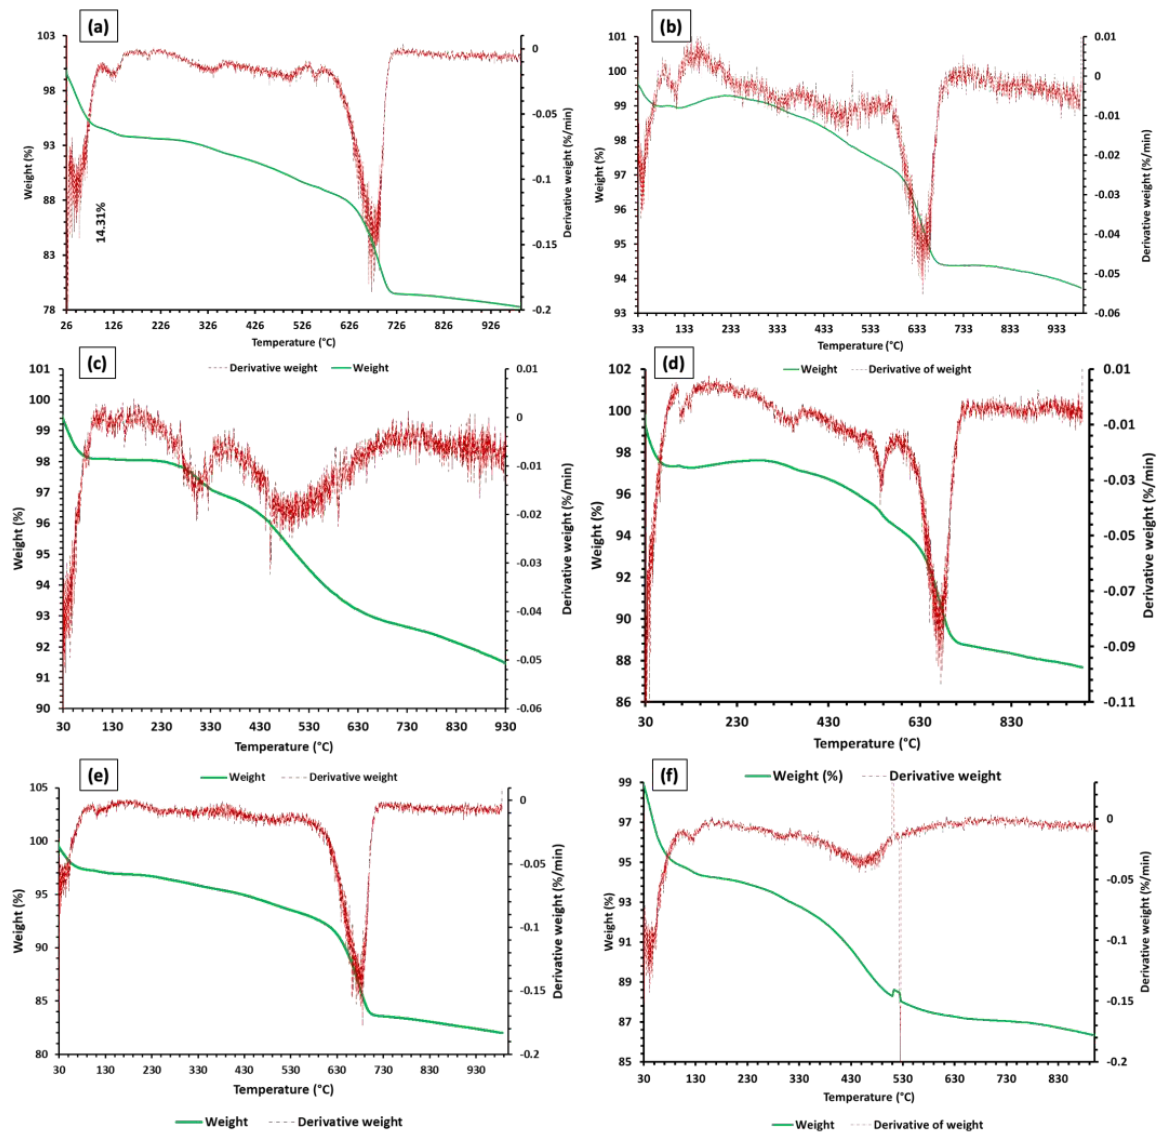
Figure 9. TGA analysis of clay minerals in ( a ): Clay I, ( b ): Clay II, ( c ): Clay III, ( d ): Clay IV, ( e ): Clay V, ( f ): Clay VI.